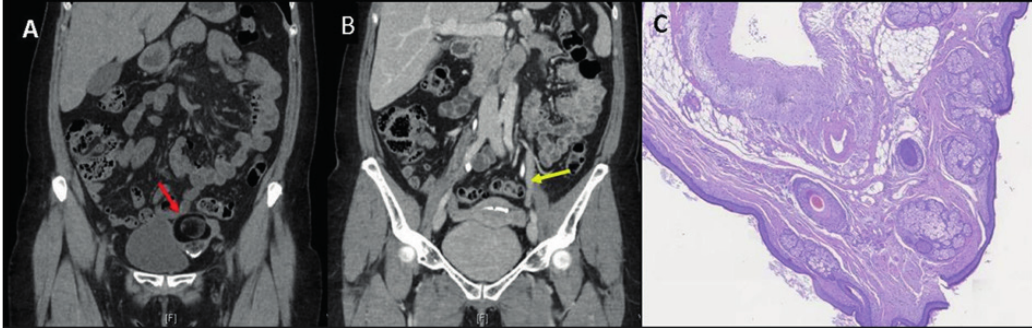
figure 2 - A) coronal abdominopelvic cT scan image revealing 5 cm left ovarian McT (red arrow); B) dilated left gonadal vein (yellow arrow); c) Histology of ovarian McT: mature hair follicles, sebaceous glands, fat cells and mature nervous